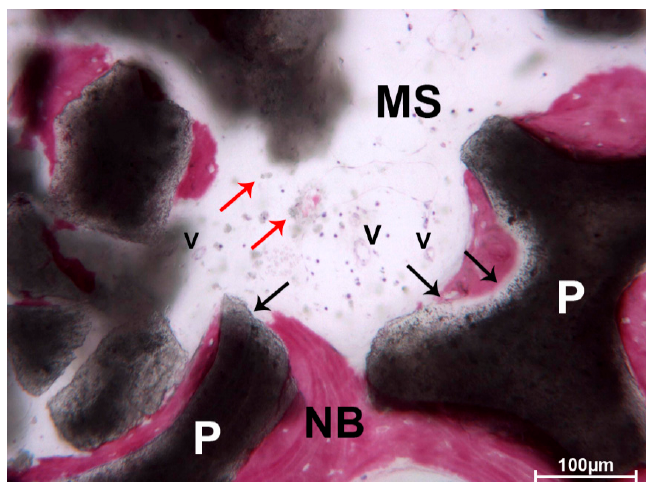
Figure 8. AAB. Mild inflammatory infiltrate and a few small-sized vessels (V) were close to the newly formed bone (NB) surrounding the AAB granules (P). Little spots of biomaterial (red arrows) were scattered in the marrow spaces (MS). The exterior margins of the granules were less dense than their inner portion (black arrows). Residual biomaterial particles (P) was in contact with newly formed bone (NB). Toluidine blue and acid fuchsin, original magnification 100×. Histomorphometry showed that newly formed bone represented 22.84%, marrow spaces 46.20%, and the residual graft material 39.94% of the total volume of the sample (Table 1).